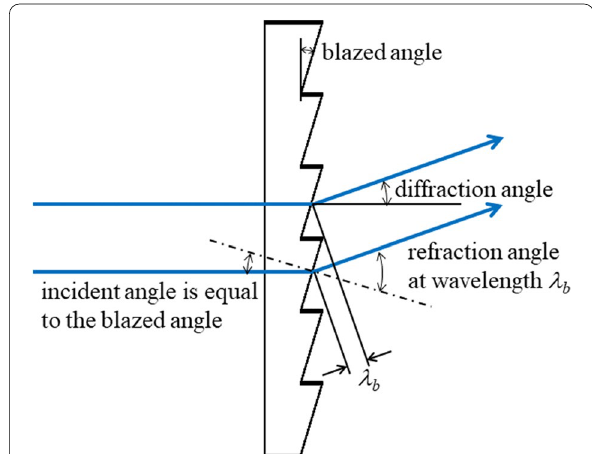
Fig. 3 Blazed-type transmission grating. A light beam of the blazed wavelength λ b refracted at the blazed surface is intensified by the interference. The blazed angle is 1.75°, and λ b is 230 nm for the grating of our spectral